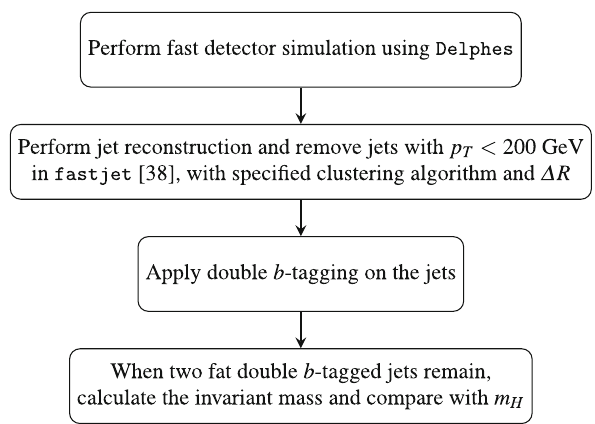
Fig. 1 Description of the procedure used to generate and analyse MC events [33–37]